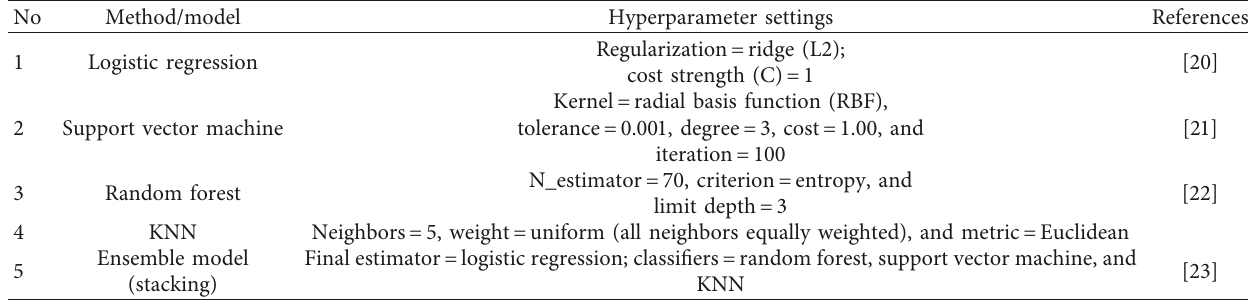
Table 3: Setting of ML model